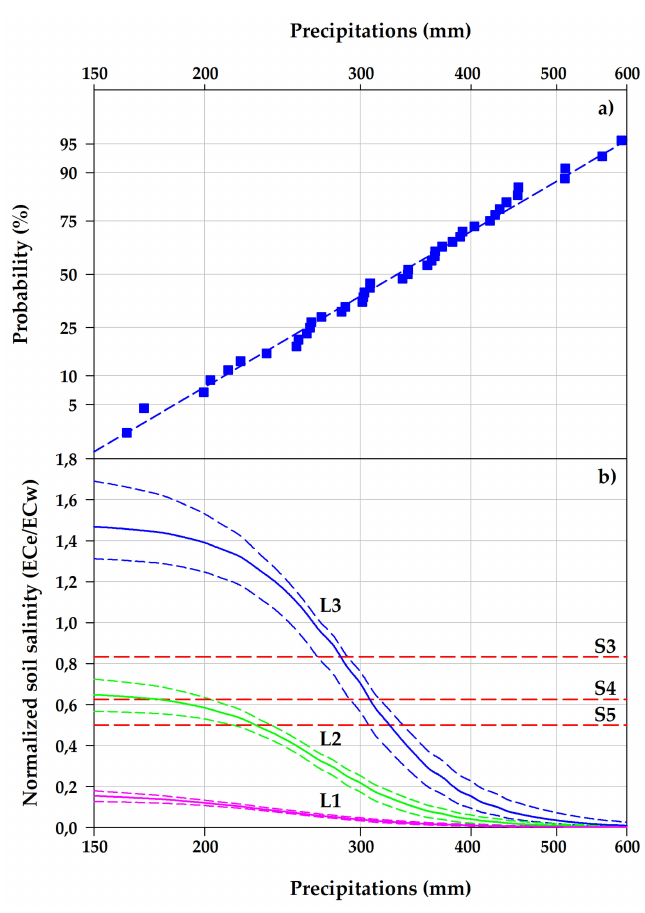
Figure 7. ( a ) Log-normal probability distribution of rainfalls detected in the fallow period (time lapse between two consecutive tomato cropping cycles) over the 43-year period of reference. ( b ) Consequent soil salinity (ECe) distribution at the start of the tomato-growing season (DY 110), expressed in normalized values with respect to the average salinity level of the irrigation water (ECw) and considering the three consecutive soil layers (L1, L2, and L3). Horizontal lines represent the threshold salinity values (corresponding to ECe = 2.5 d m − 1 ) for S3, S4, and S5, respectively. Salinity values above the threshold reduce the potential yield of tomato